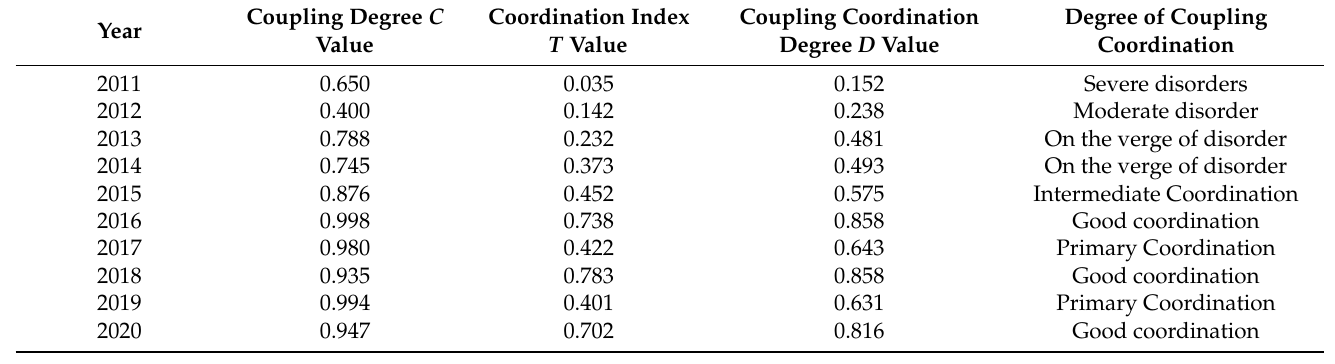
Table 3. The time-series status of the coupling and coordination degree of China’s agricultural modernization and regional economic development system.